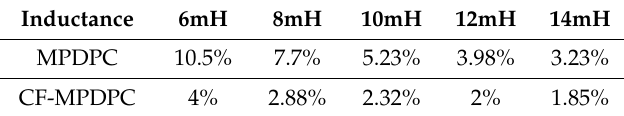
Figure 10. Current total harmonic distortion (THD) comparison for a fault-tolerant BVSC with various inductance values. Table 3. Current THD comparison for a fault-tolerant BVSC.